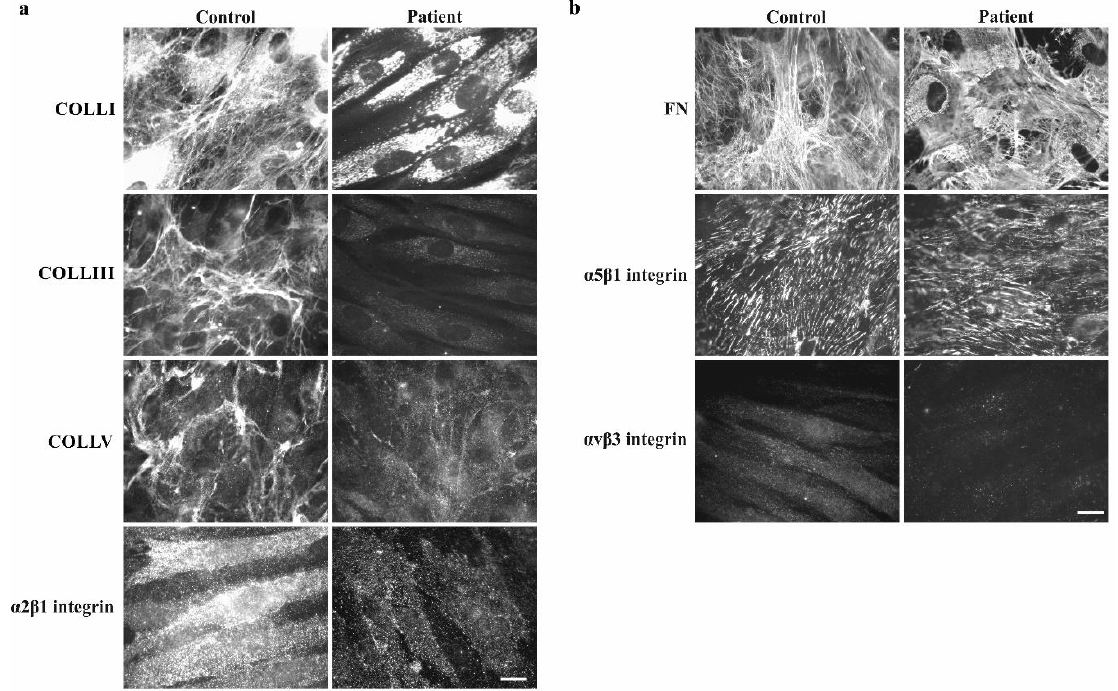
Figure 4. TNX-deficiency leads to the disarray of collagens type I, type III and type V in the ECM together with the reduction of the α 2 β 1 integrin. ( a ) IF analysis with specific Ab demonstrates that TNX-deficient cells are characterized by the lack of organized COLLI, COLLIII and COLLV in the ECM, though proteins are present at di ff erent levels inside the cells. The disorganization of the COLLs-ECM is associated with a strong reduction of their canonical α 2 β 1 integrin receptor. ( b ) TNX-deficient cells deposit FN in the ECM and express its canonical integrin receptor α 5ß1 similarly to control fibroblasts. The alternative α v β 3 integrin is almost undetectable both in control and patients’ cells. Scale bars: 10 μm.